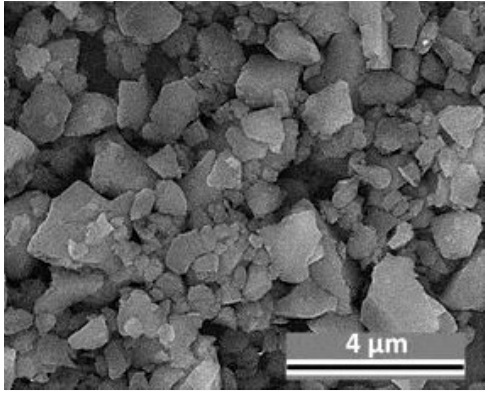
Figure 9. The structure of mullite. Table 2. The intensity of γ -Al 2 O 3 peaks in the microarc oxidation (MAO) coatings formed on aluminum alloys at different anode pulse-widths.